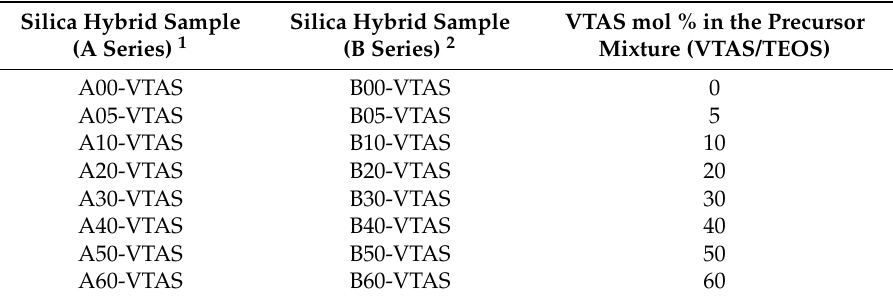
Table 1. Sol-gel synthesis